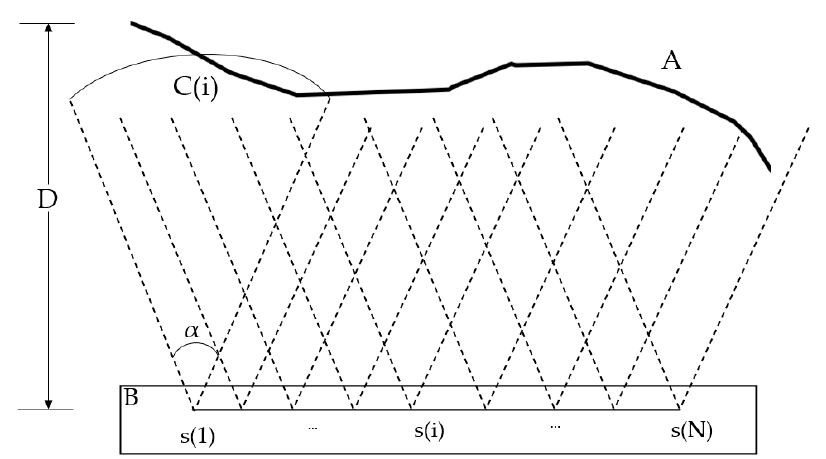
Figure 3. Geometric deployment of the camera sensor network, where curve A is the surface, B is